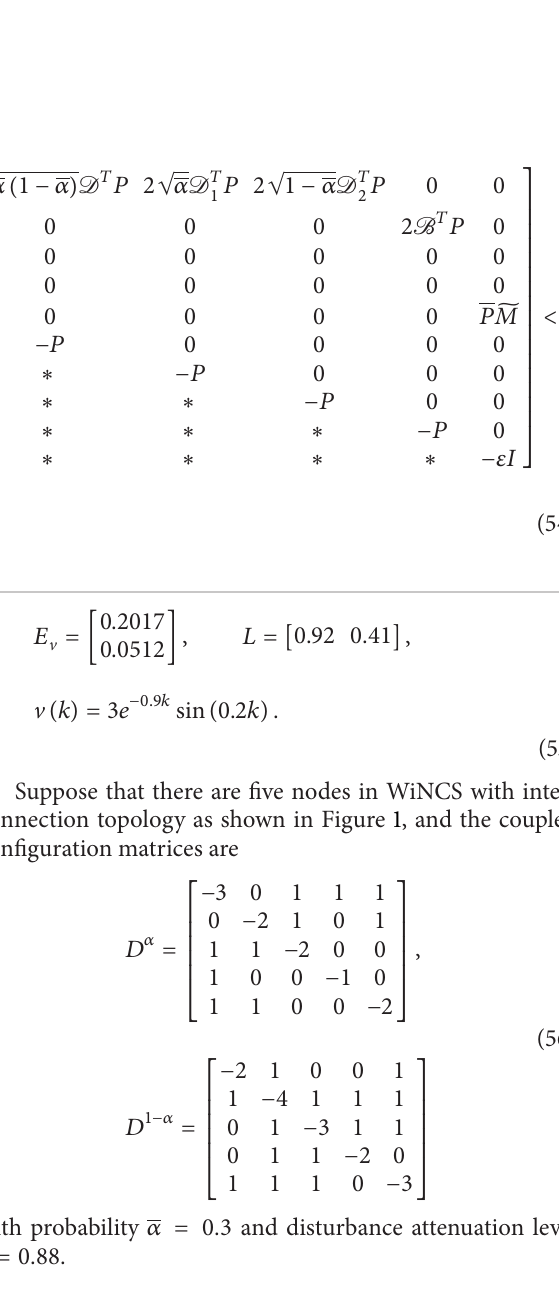
Figure 1: Two topology structures of